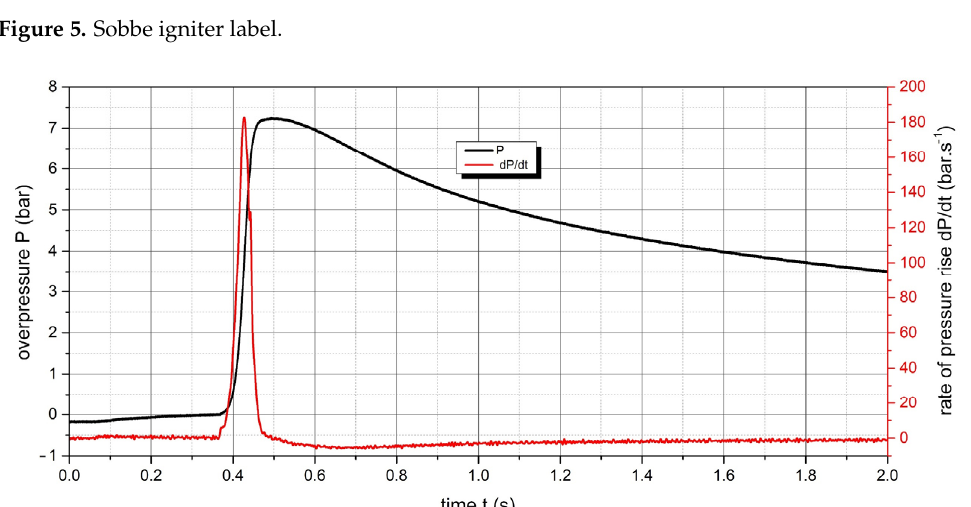
Figure 5. Sobbe igniter label.